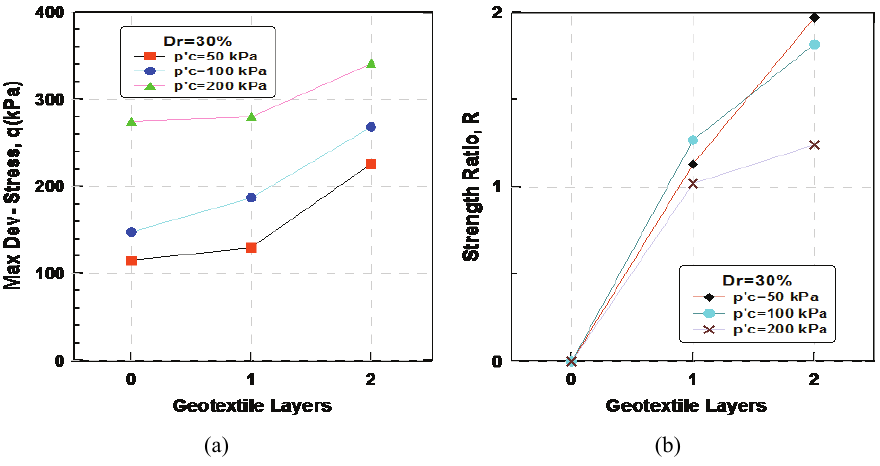
Fig. 13. Maximum deviator stress and strength ratio versus geotextile layers for different confining